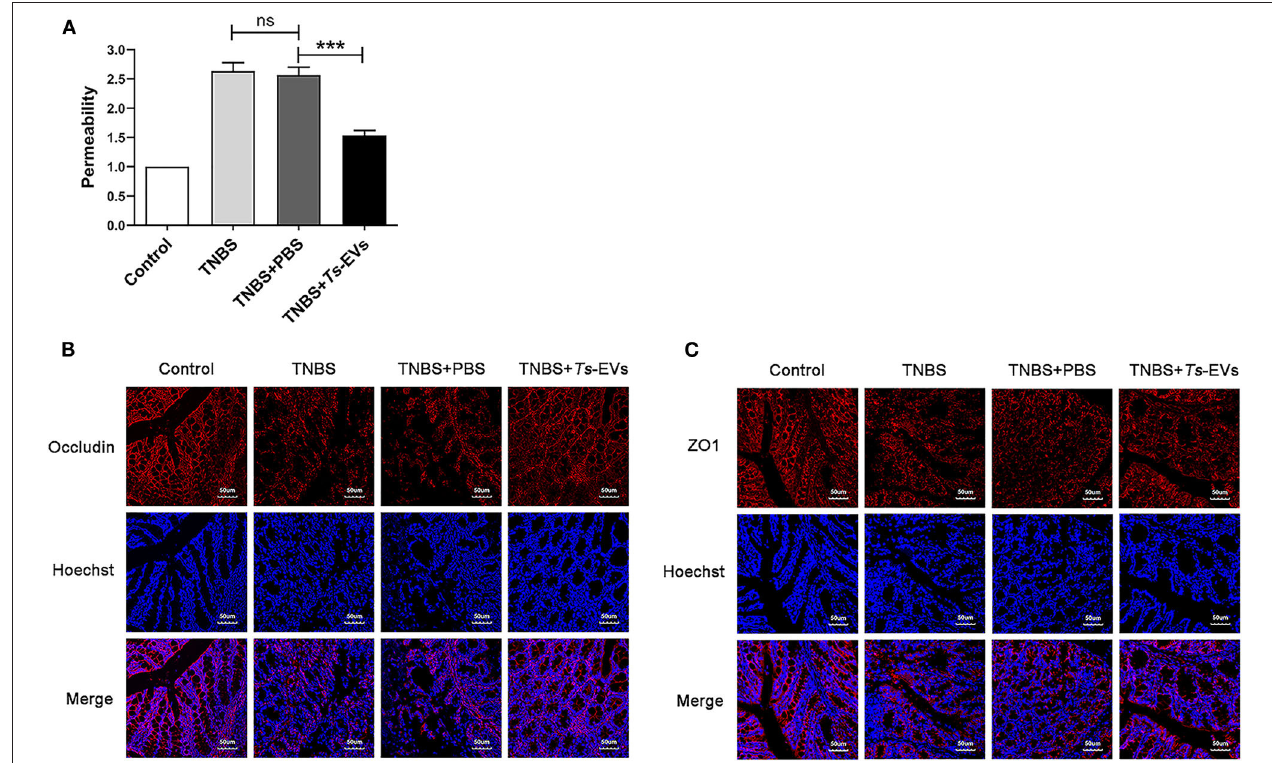
FIGURE 4 | Ts -EVs restored the impaired permeability and preserved tight junctions integrity inTNBS-induced colitis. (A) Intestinal permeability was measured by FITC-Dextran permeability assay. Relative permeability of TNBS and Ts -EV treatment in mice. Results are shown as mean ± SD of each group ( n = 3). Statistical analysis was performed with one-way ANOVA followed by Tukey’s multiple-comparison test. *** p < 0.001. (B,C) Tight junction proteins were measured by using laser scanning confocal microscopy. (B) Colonic occludin (red), nuclei (blue). (C) Colonic ZO-1 (red), nuclei (blue). Magnification of the images was 400 × , Scale-bars = 50 µ m. These figures are representative of three independent